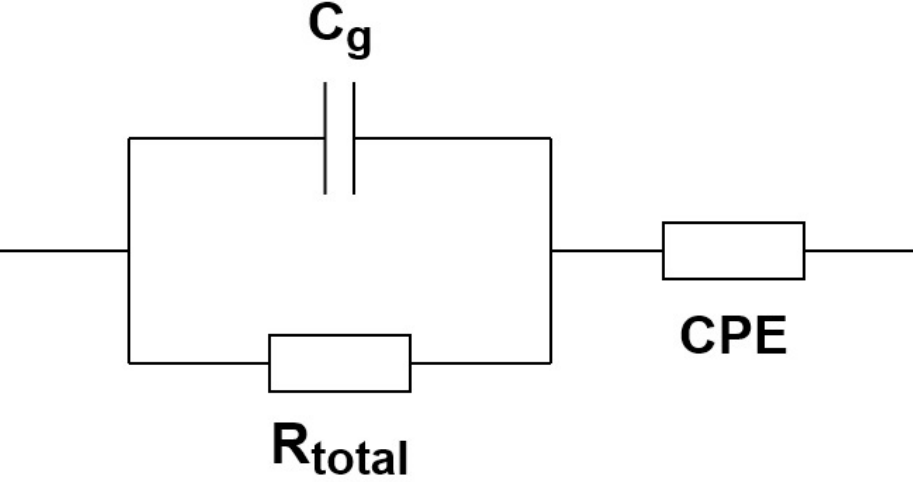
Figure 1. Resultant equivalent circuit for Ag │ Li 6-x Zr 2-x Nb(Ta) x O 7 │ Ag cell. The impedance spectra for the undoped Li 6 Zr 2 O 7 and for the solid solutions are identical. The spectra for the Ag|Li 5.95 Zr 1.95 Nb 0.05 O 7 |Ag cell at different temperatures are given in Figure 2 as examples. At low temperatures the spectra consist of a semicircular arc in the high-frequency region and a tail in the low-frequency region (Figure 2a).